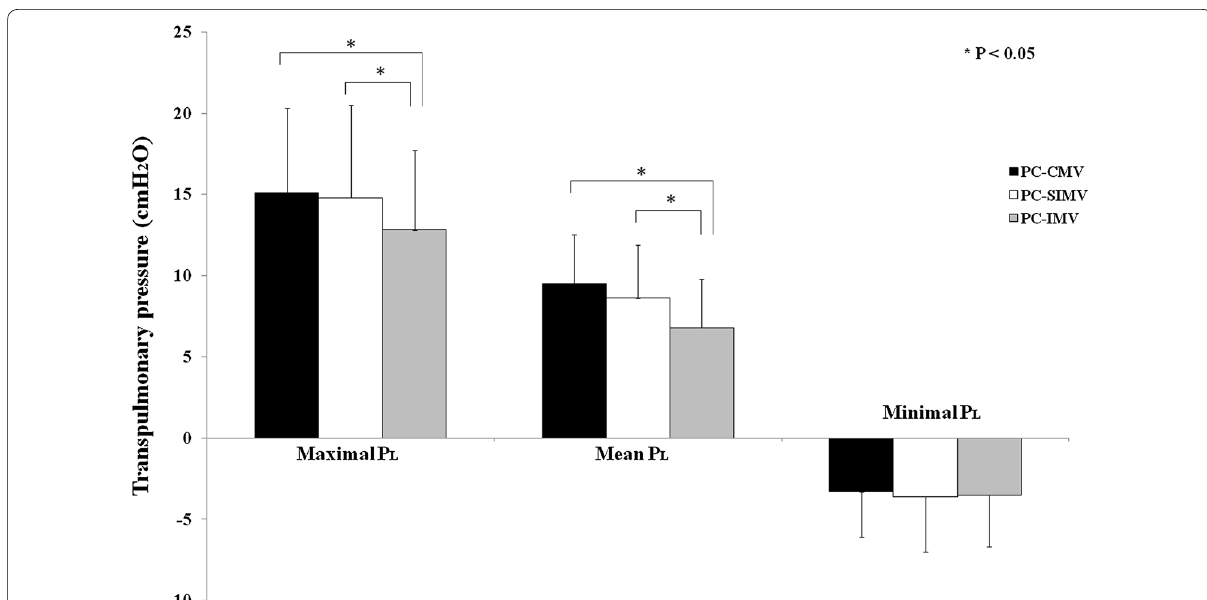
Fig. 3 Maximal, mean, and minimum transpulmonary pressure ( P L ) during the three pressure‑controlled modes of ventilation. PC-CMV pressure‑ controlled continuous mandatory ventilation, PC-SIMV pressure‑controlled synchronized intermittent mandatory ventilation, PC-IMV pressure‑ controlled intermittent mandatory ventilation